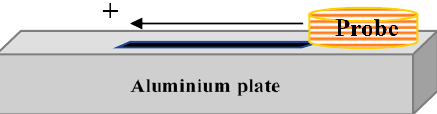
FIGURE 9. Schematic of the scanning tests.